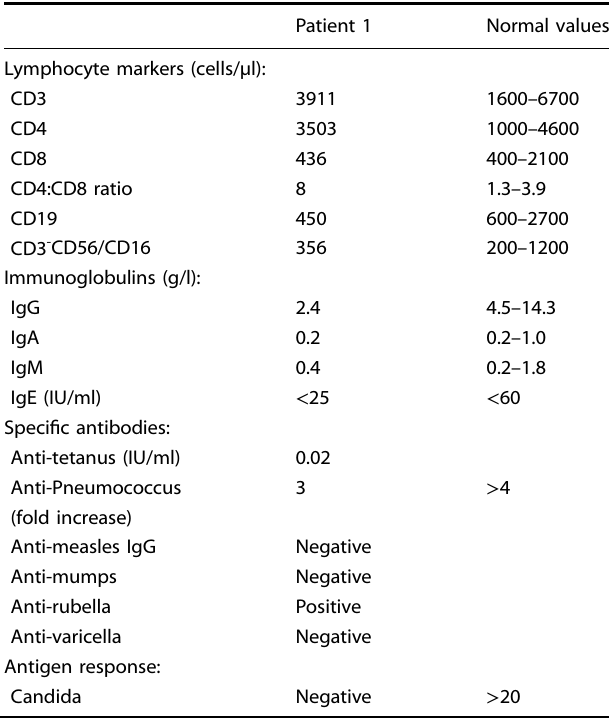
Table 2. Patient 1 – immune work up